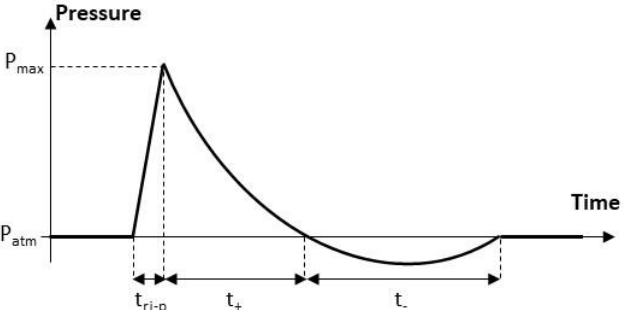
Figure 1. Typical pressure variation during an air blast experiment ( P atm denotes the atmospheric pressure before the shock wave, P max is the pressure peak, t ri − p is the rise time of the pressure; t + and t − denote the durations of the positive and negative phases, respectively).